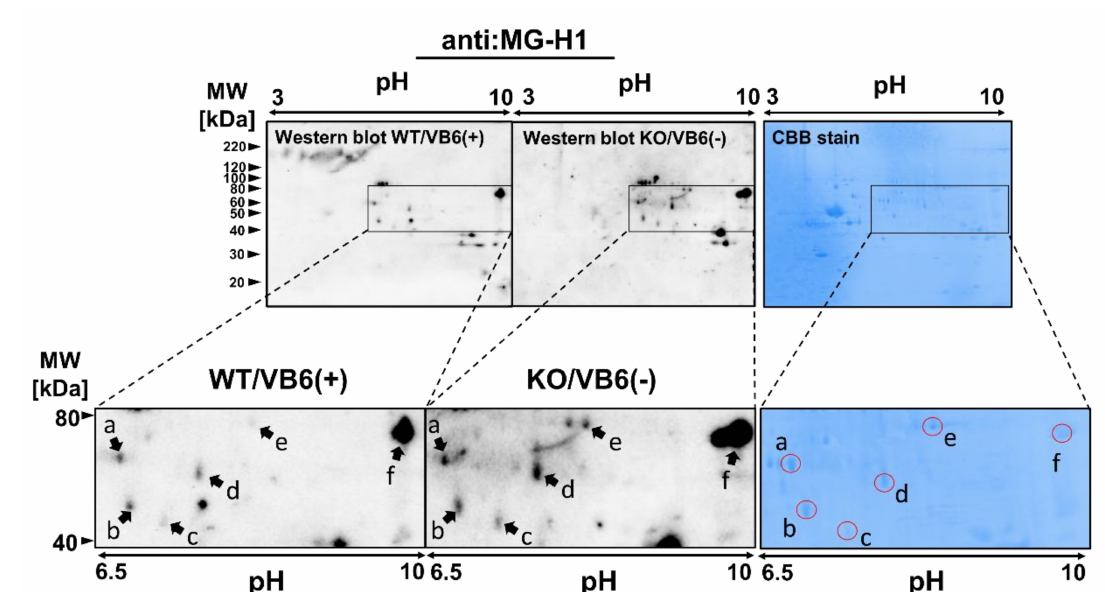
Figure 4. Identification of MG-H1-modified proteins in the HIP from KO/VB6( − ) mice. HIP homogenates of WT/VB6(+) mice or KO/VB6( − ) mice were separated by two-dimensional gel electrophoresis. MG-H1-modified proteins were identified by Western blot analysis using anti-MG-H1 antibody. The left and middle panels show MG-H1-modified proteins detected by Western blot analysis after two-dimensional gel electrophoresis in the HIP of WT/VB6(+) mice and KO/VB6( − ) mice, respectively. A typical result from the other two samples providing similar results is presented. HIP samples of WT/VB6(+) mice or KO/VB6( − ) mice were subjected to two-dimensional gel electrophoresis followed by CBB staining. The right panel shows a two-dimensional gel image with the CBB staining pattern. The specified spots (spot a, b, c, d, e, and f) were excised and digested in-gel for LC-MS/MS analysis. Table 1. List of MG-H1-modified proteins in HIP of KO/VB6( − ) mice #, identified with LC-MS/MS analysis. Spot Accession